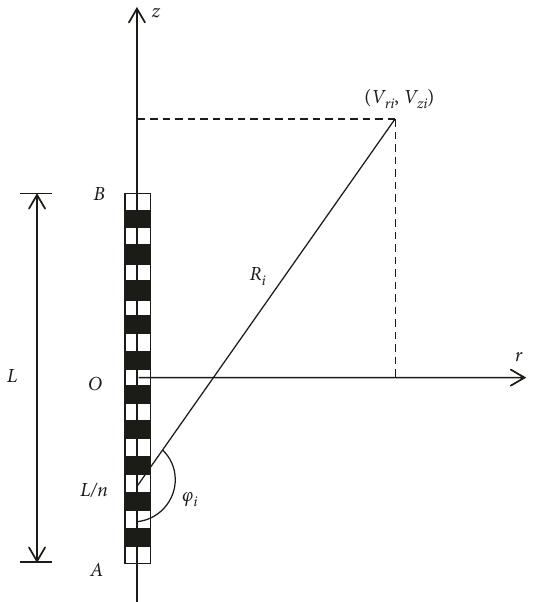
Figure 6: Computation model of the blast vibration field of an extended cylindrical charge.